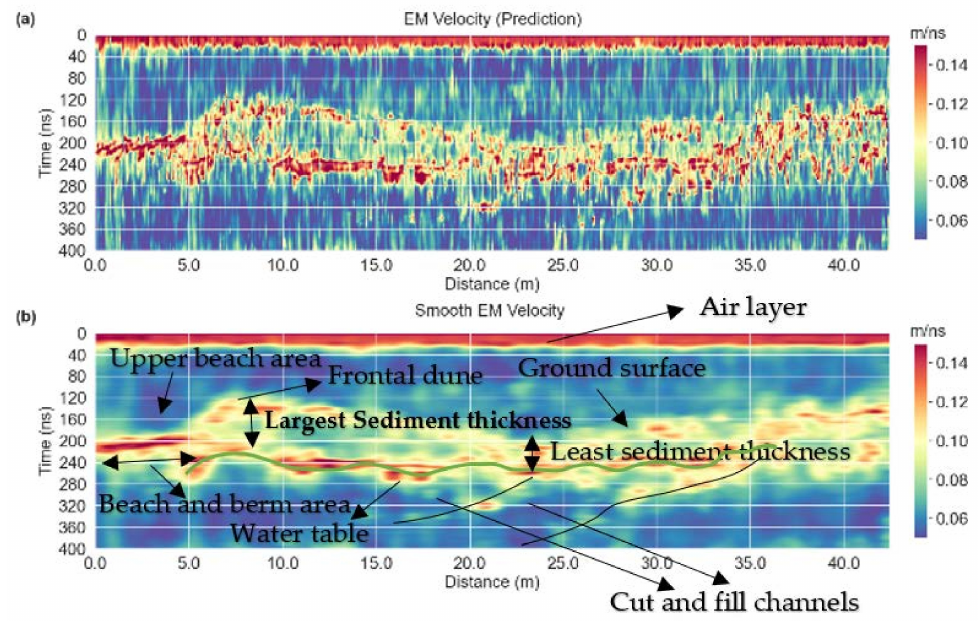
Figure 11. ( a ) The DCNNs based inverted 2D EM velocity model. ( b ) The smoothed 2D EM velocity model obtained using Gaussian